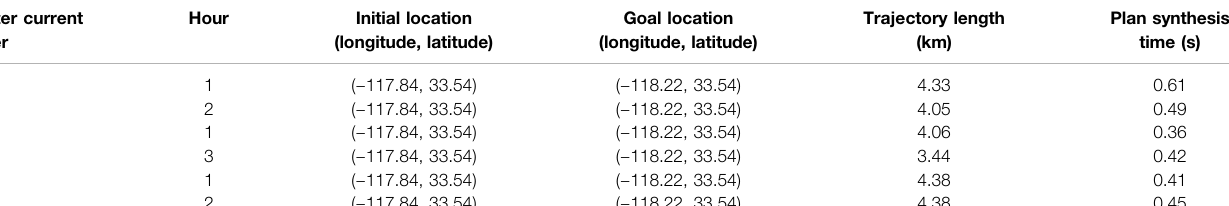
TABLE 1 | Comparison of executed trajectory lengths using synthesized feedback plans for several water current layers along with plan synthesis times for a number of hours. Water current layer